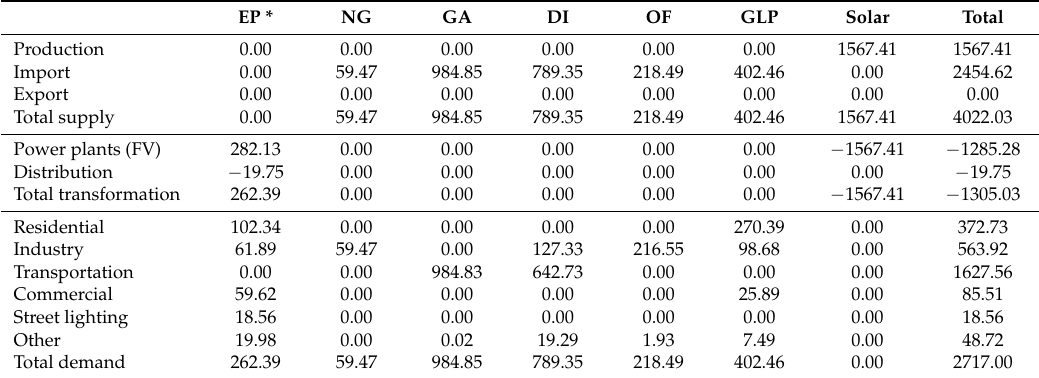
Table 9. The energy balance E S1